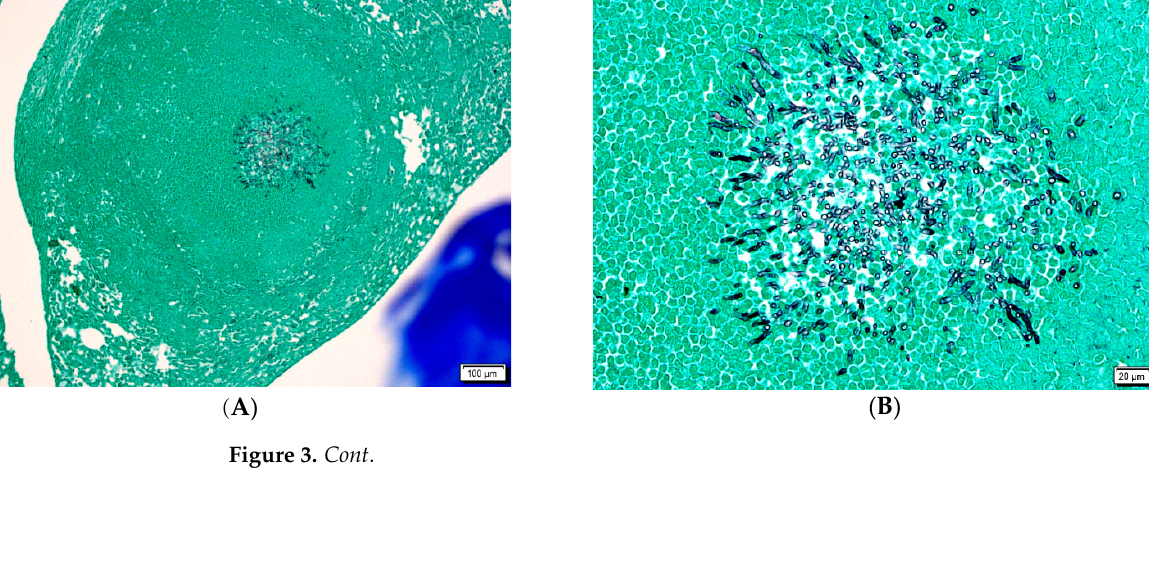
( F ) Figure 3. ( A – F ). ( A , B ): aspergilloma in the lung of infected animal with GMS stain. ( C , D ): aspergil ‐ loma in the lung of infected and AMB treated animal with GMS stain. ( E , F ) lung of infected and DIMICAN treated animals with GMS strain. Scale bars ( A , C , E ) are 200 μ m. Scale bars ( B , D , F ) are 20 μ m. We studied the effect of DIMICAN on not ‐ infected animals and we did not observe any behavioral changes. DIMICAN caused elevated glycogen accumulation in the liver, and the hepatocytes structure changed to foamy (Figure 4A–D). Later, the glycogen level decreased to normal levels and hepatocytes were similar to animals not treated with DIM ‐ ICAN (Figure 4A–D). For the formulation of DIMICAN we used olive oil, which leads to glycogen accumulation in the liver (Figure 4A,B).